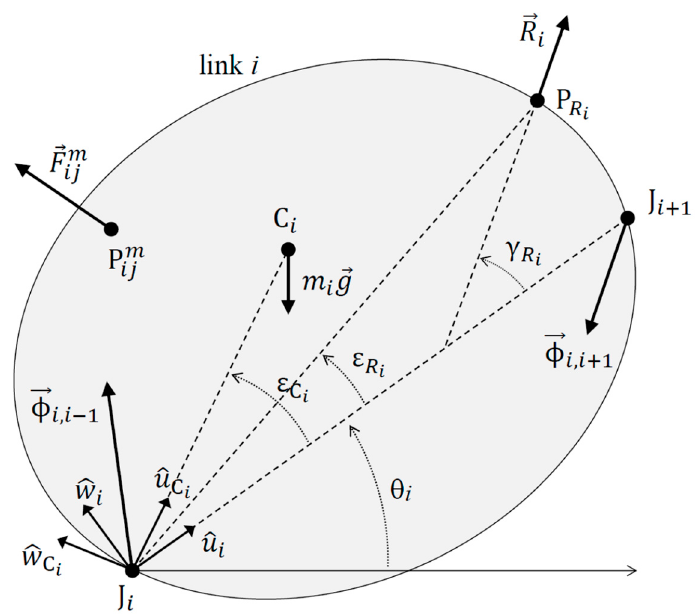
Figure 1. Mechanical diagram of the individual link i of the chain. The diagram includes the forces acting on the link, and the relevant points, unit vectors, and angular quantities associated with the link. The definition of these quantities is also reported in the “Nomenclature”.